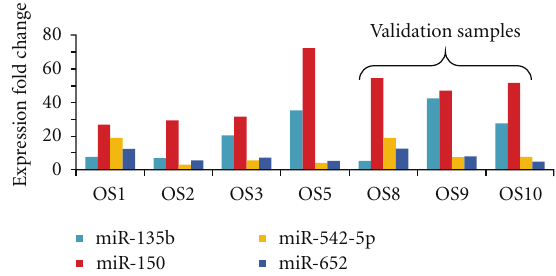
Figure 2: Overexpression of selected miRNAs in osteosarcoma tumor samples. Individual miRNA assays were performed with the 4 initial samples confirming the di ff erential expression of 4 miRNAs that were identified when compared to normal osteoblasts in the first screening. A “test set” comprising of three additional tumors was used to further validate these findings. Table 2: Mean expression fold changes of candidate miRNAs in 7 human tumors as compared to normal osteoblasts. miRNA Average fold change Standard deviation hsa-miR-135b